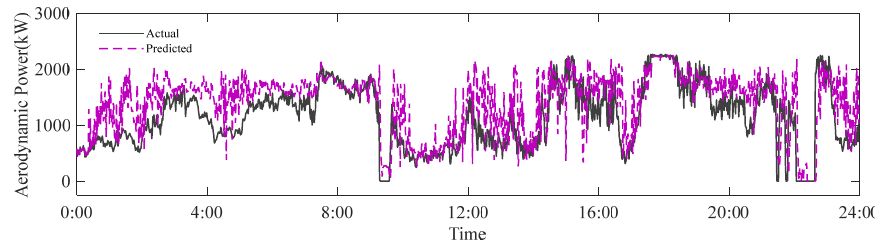
Figure 11. The result of the aerodynamic power prediction model on 16 March 2022.